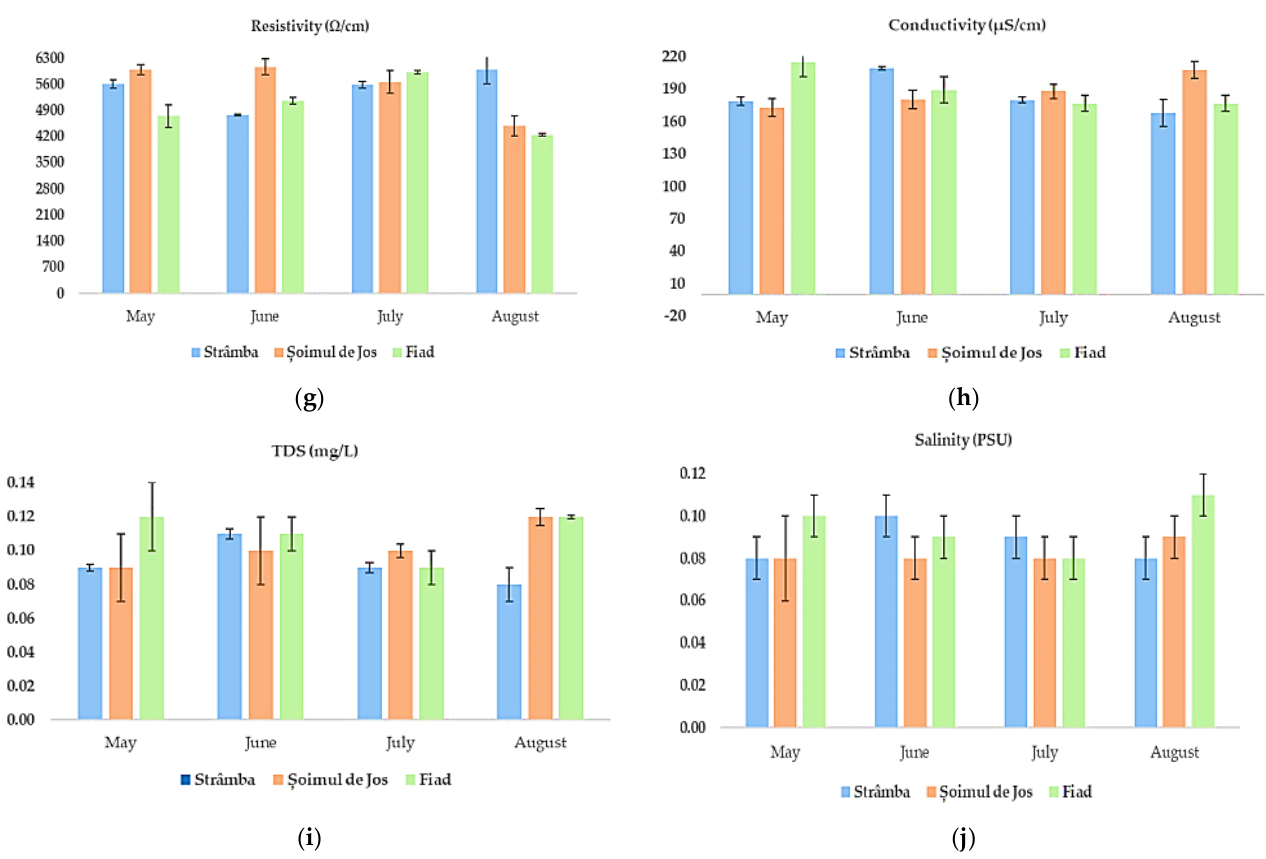
Figure 1. Physicochemical parameters of water (mean ± standard deviation) determined monthly during the summer season: ( a ) temperature (°C); ( b ) dissolved oxygen (mg/L); ( c ) pH (pH/ORP meter); ( d ); nitrites (mg/L) ( e ) nitrates (mg/L); ( f ) ammonia (mg/L); ( g ) resistivity (Ω/cm) ; ( h ) conductivity (µS/cm); ( i ) total dissolved solids (TDS); ( j ) salinity (PSU).